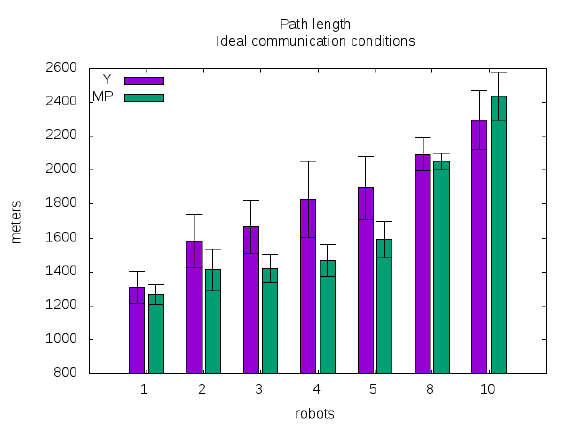
Figure 14. Path length (PL) under ideal communication conditions. The trend of PL is upward in both